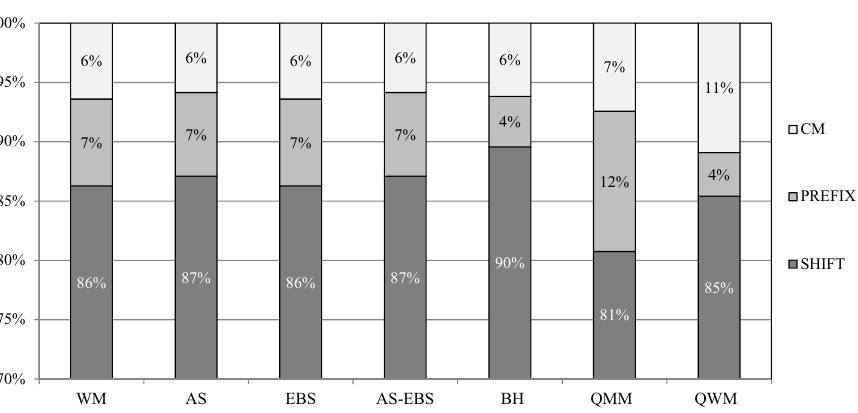
Figure 14. Detection accuracy of each matching